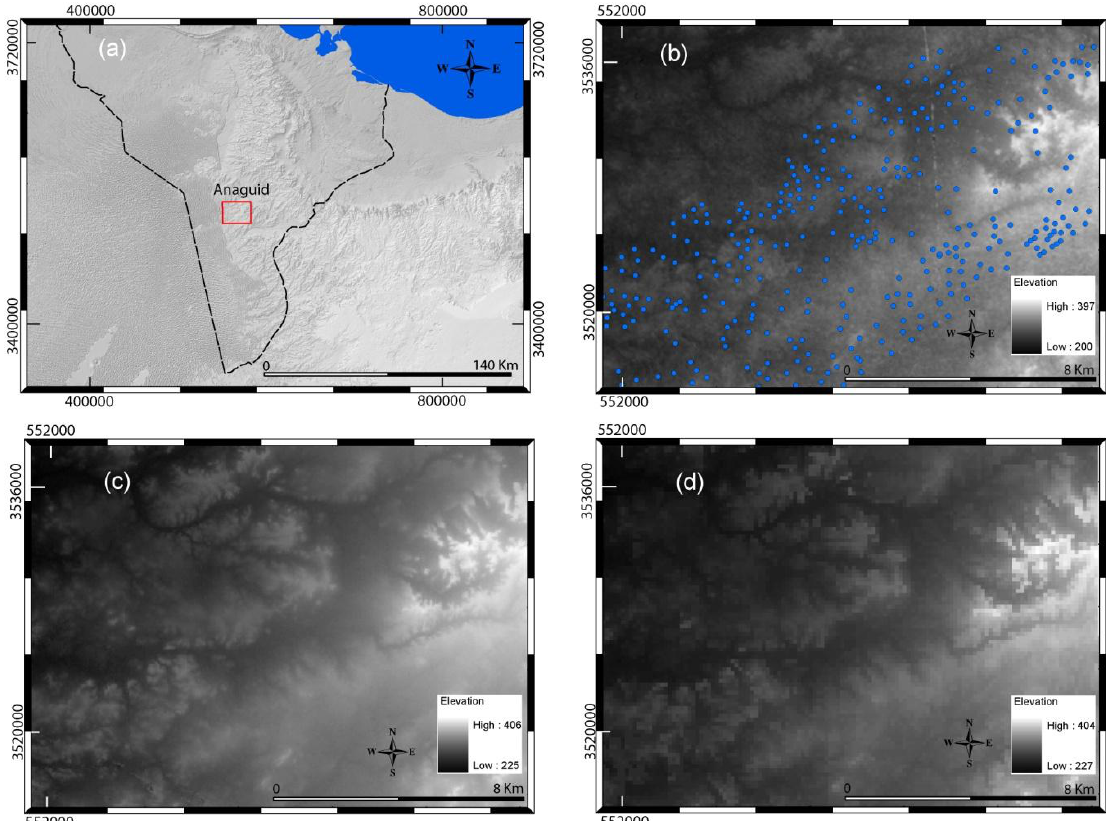
Figure 3. Data used for Anaguid test site. ( a ) Location of the Anaguid Saharan platform, ( b ) RTK-DGPS reference data plotted on ASTER GDEM2, ( c ) SRTM v.4.1 and ( d ) systematic subsample GMTED